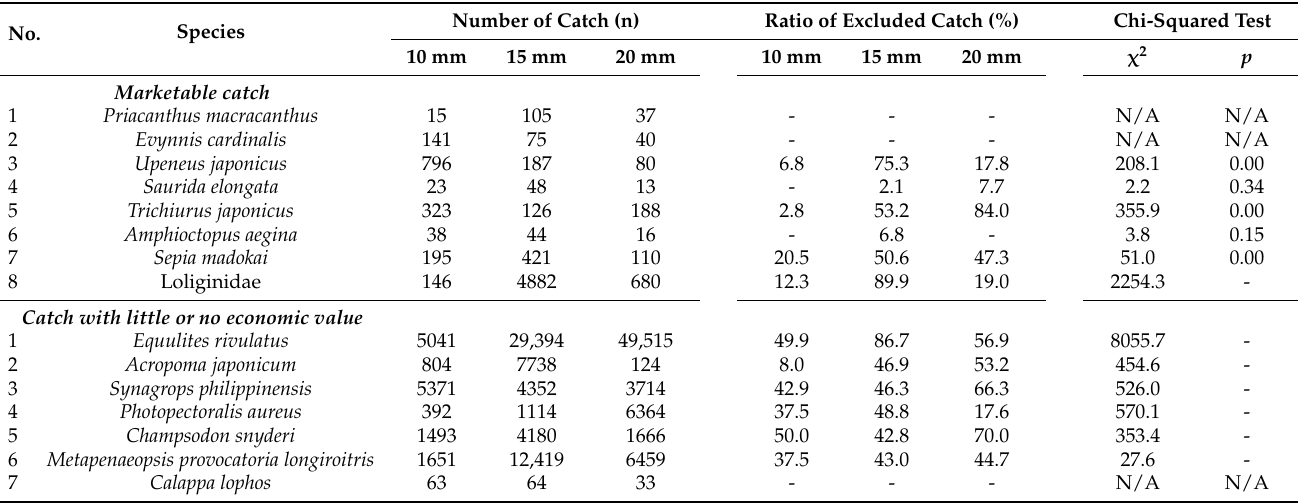
Table 5. Number of catches excluded by proposed